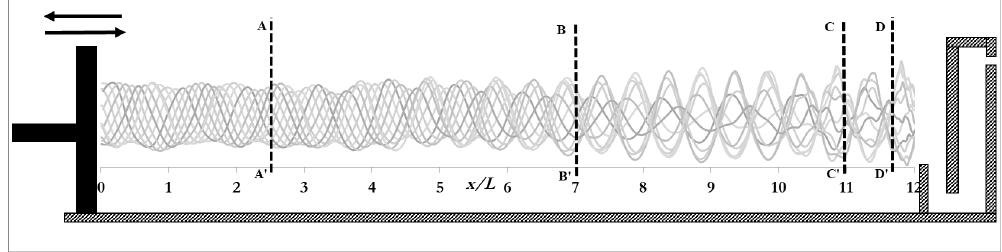
Figure 11. The envelope of the water free surface displacement from 25 T to 26 T , with the position of the vertical cross sections ( H = 2.5 m, T = 8